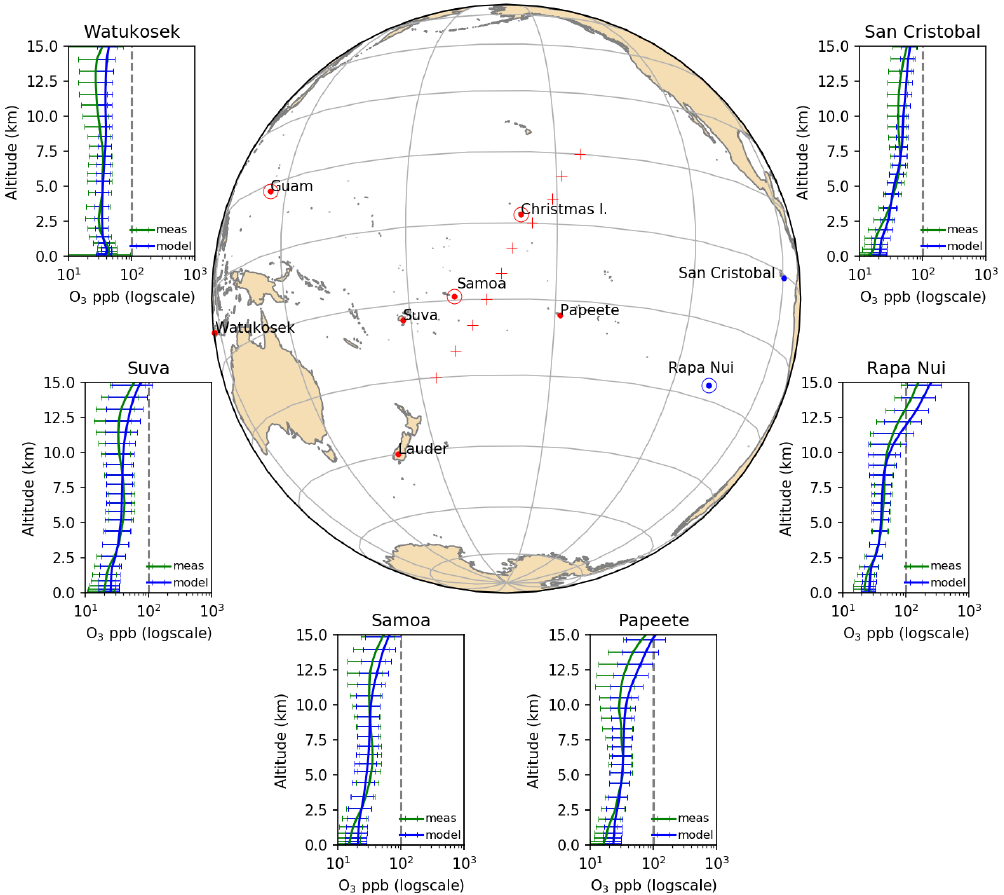
Figure 1. Area of study and ozone profile climatologies (1994–2014) as derived from the observations and simulations for six sites in the remote Pacific (red dots). The location of the stations is shown on the map. Also shown are the stations where surface CO measurements were considered (red + symbol). Ozone measurements are shown in green and simulations in blue. The error bars correspond to 1 standard deviation of the mean. The vertical grey line represents the chemical tropopause (100ppb for the Southern Hemisphere, Prather et al., 2011). The Rapa Nui and Samoa stations, where both O 3 and CO observations are available, are marked with a dot and circle. Ozone data were obtained from https://tropo.gsfc.nasa.gov/shadoz/ (last access: 4 December 2018), except for Rapa Nui, which was accessed at http://www.cr2.cl/datos-ozonosonda/ (last access: 23 March 2018). CO data come from https://www.esrl.noaa.gov/gmd/dv/data/ (last